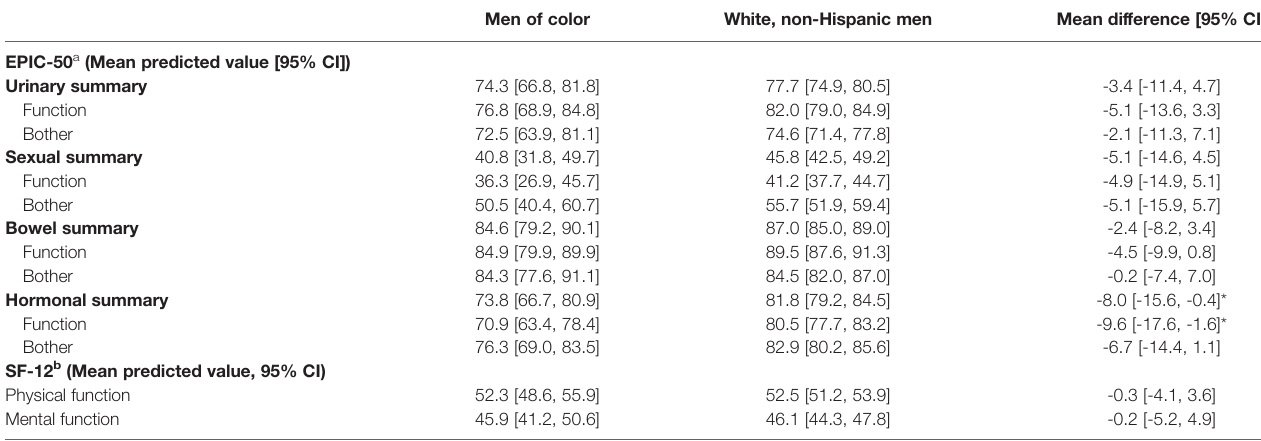
TABLE 3 | Unadjusted Health-Related Quality of Life (HRQOL) outcomes for Sexual Minority Prostate Cancer Survivors by Racial and Ethnic Group (N=190). Men of color White, non-Hispanic men Mean difference [95% CI] EPIC-50 a (Mean predicted value [95% CI]) Urinary